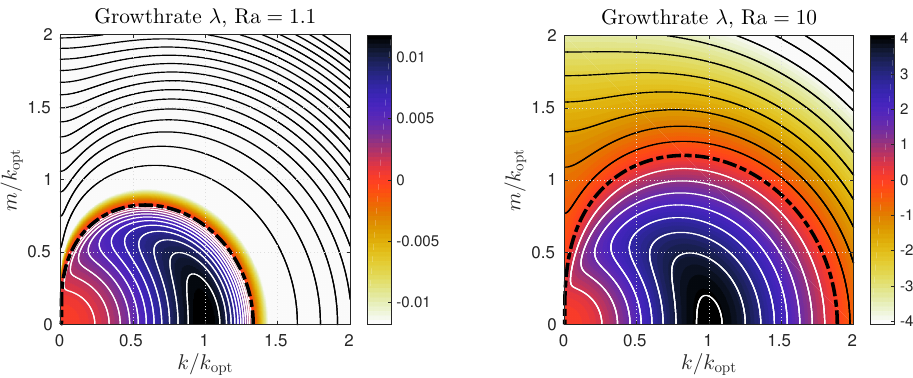
Figure 1. Contour plots of the linear growth rate λ ( k , m ) of the reduced model (20). The left panel shows the results for Ra = 1.1 with equispaced contours separated by 0.001 for positive values and 0.05 for negative values; the right panel shows the results for Ra = 10 with equispaced contours separated by 0.5.